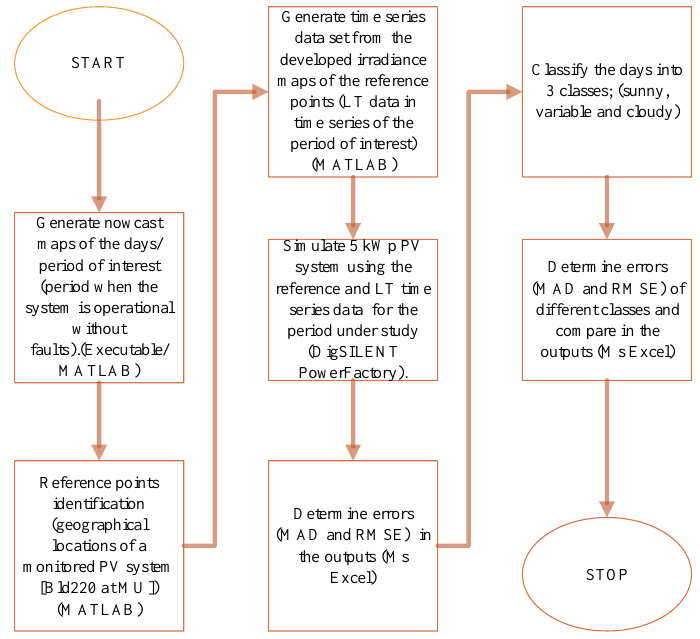
Figure 4. ASI nowcasting system validation